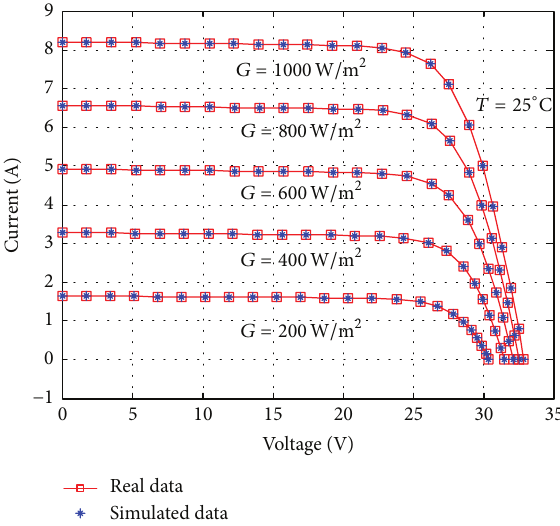
Figure 10: Comparison between real data and the simulated data by PCE for monocrystalline SM55 at different irradiances.